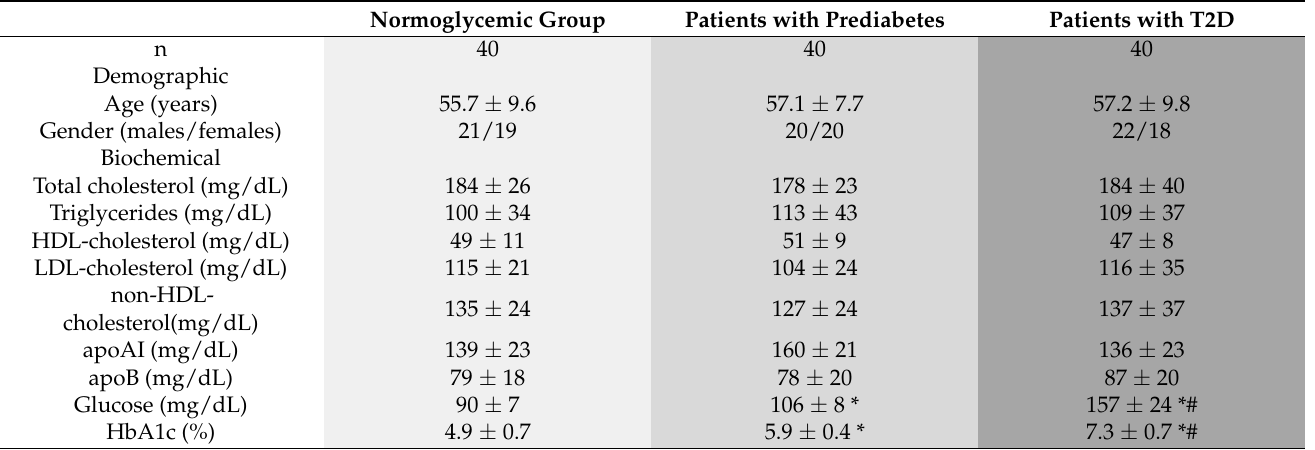
Table 1. Demographic and biochemical characteristics of the study’s